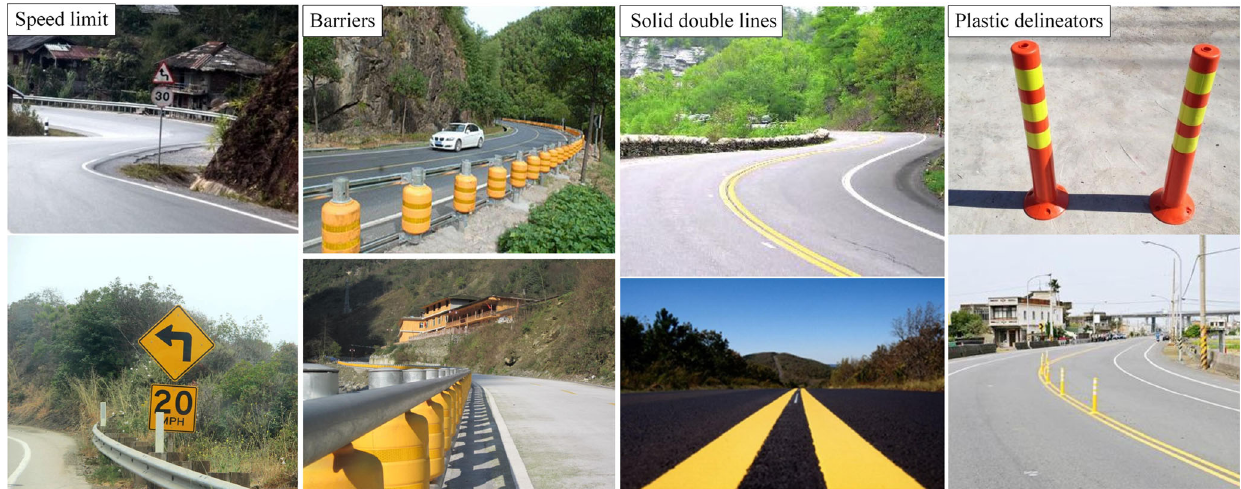
Fig. 11 Safety countermeasures for preventing passive lane departures or inhibiting the behavior of curve